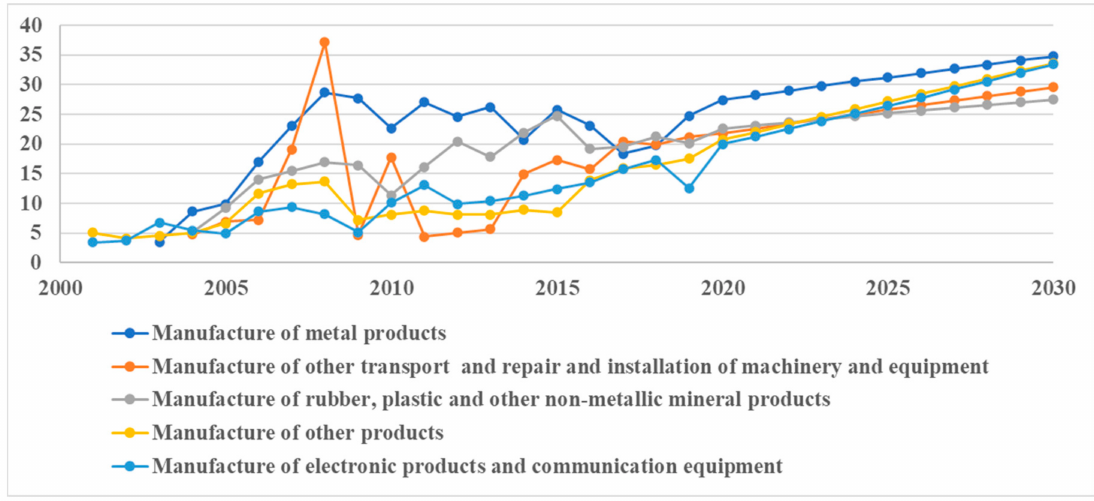
Figure 13. Real labour productivity till 2030, EUR/h (own